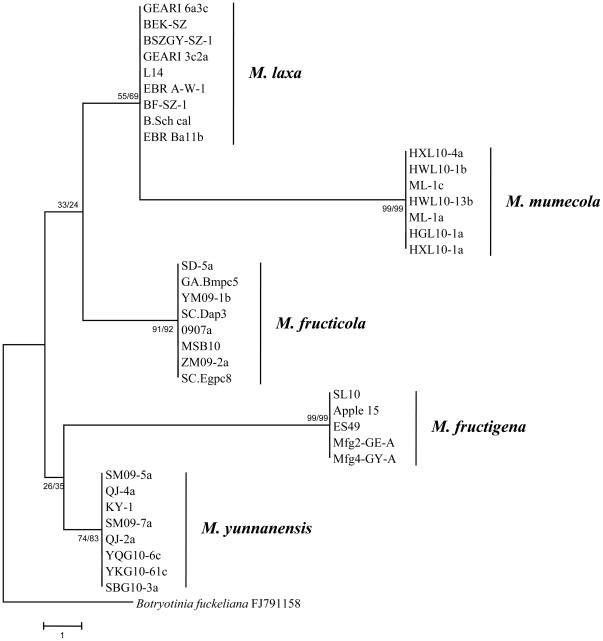
Phylogeny of the rDNA region ITS1-5.8S-ITS2.Shown is the most parsimonious tree for 37 Monilinia isolates and one outgroup species (Botryotinia fuckeliana), with 437 characters, out of which 18 were parsimony informative. The numbers labeled at each node indicate the bootstrap (BS) percentages (N = 1000) supporting individual branches: BS value from the MP test/BS value from the neighbor-joining (NJ) test.